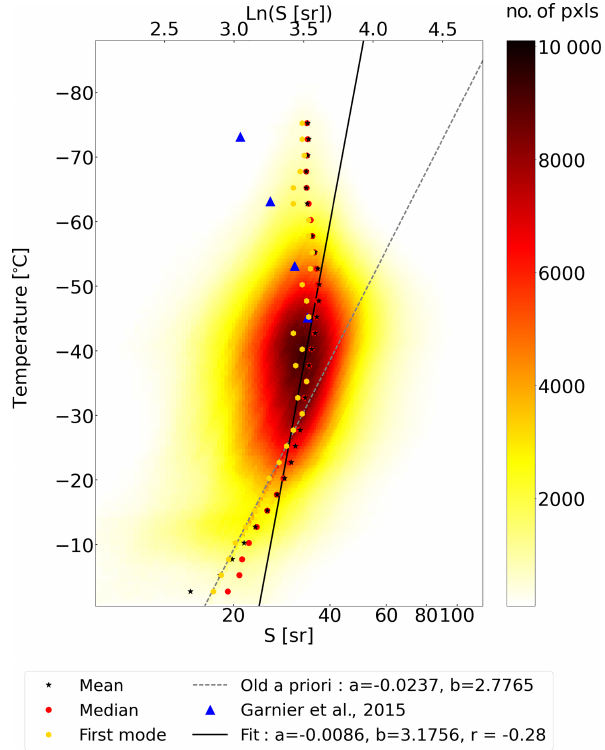
Figure 1. Linear regression on the probability density distribution of ln (S) as a function of temperature. The corresponding values of S in steradian (sr) are also displayed. The result of the linear re- gression fit is represented by solid lines and the old a priori rela- tionship by dashed lines. Red and yellow dots are the median and first mode (respectively). The parameterization obtained with the re- trievals from Garnier et al. (2015) is also displayed for comparison (blue